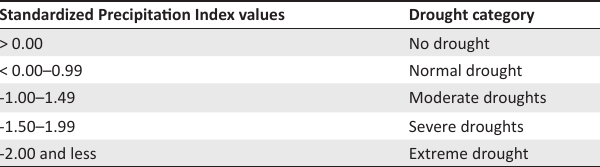
TABLE 1: Drought category. Standardized Precipitation Index values Drought